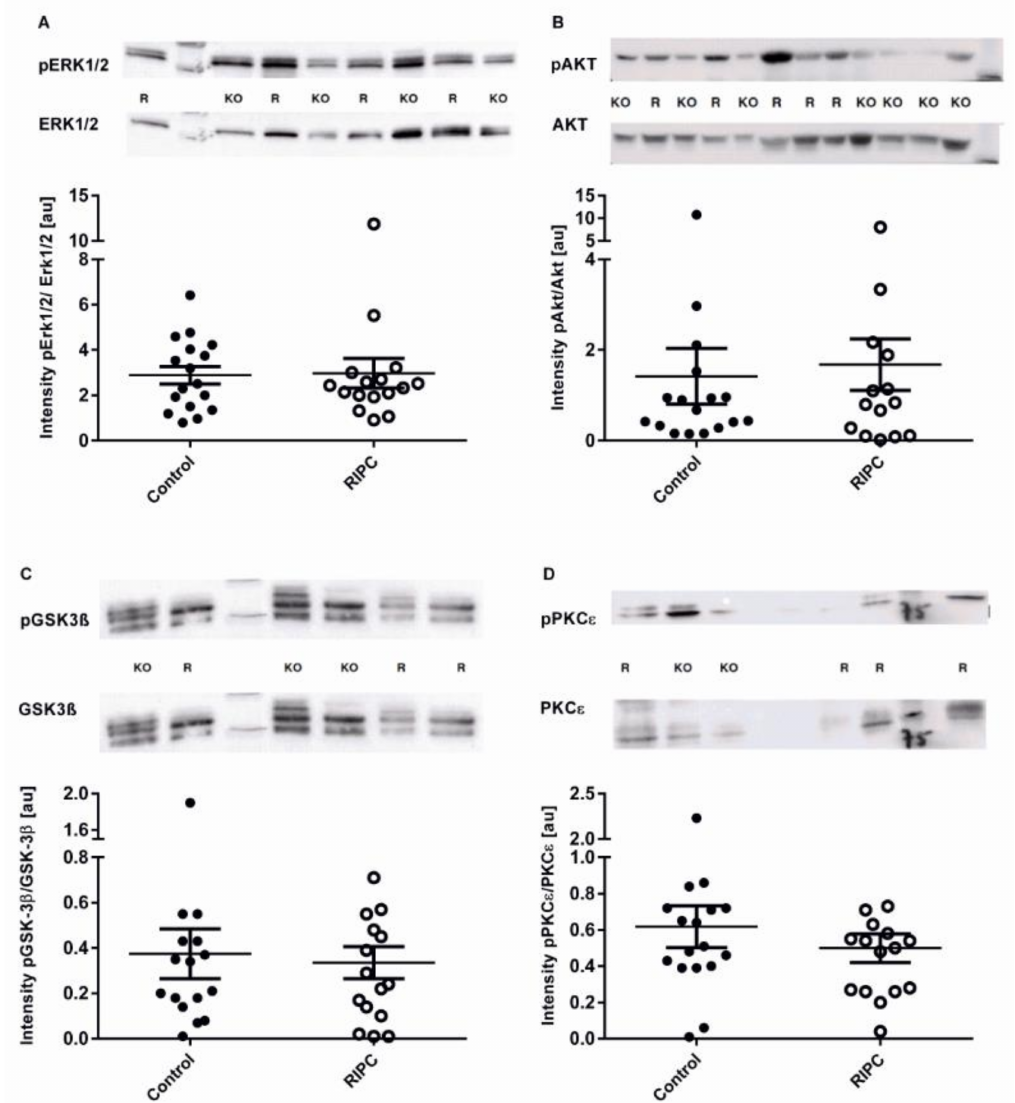
Figure 4. Extracellular-signal regulated kinase (ERK1/2), protein kinase B (AKT), GSK-3 β , and protein kinase C (PKC ε ) activity on the RIPC in heart tissue. Densitometric analysis of ERK1/2, AKT, GSK-3 β , and PKC ε content in myocardial atrial tissue collected while connecting to the cardiopulmonary bypass (CPB). Relative phosphorylation of ( A ) ERK1/2, ( B ) AKT, ( C ) GSK-3 β , and ( D ) PKC ε were assessed by Western blotting and normalized to the unphosphorylated proteins. Data represents means ±